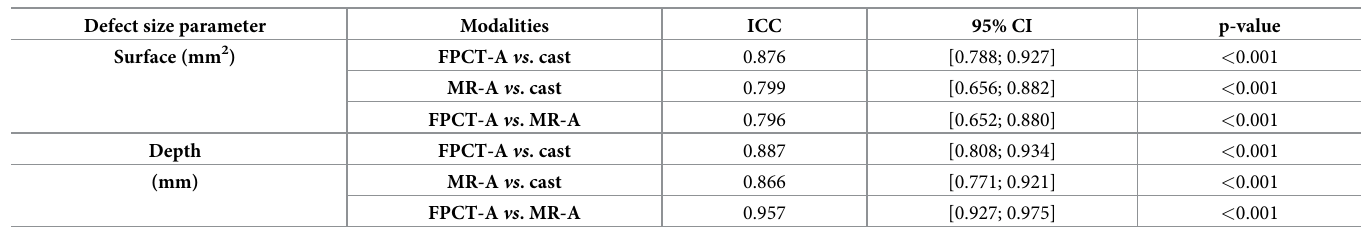
Table 5. Correlation results.